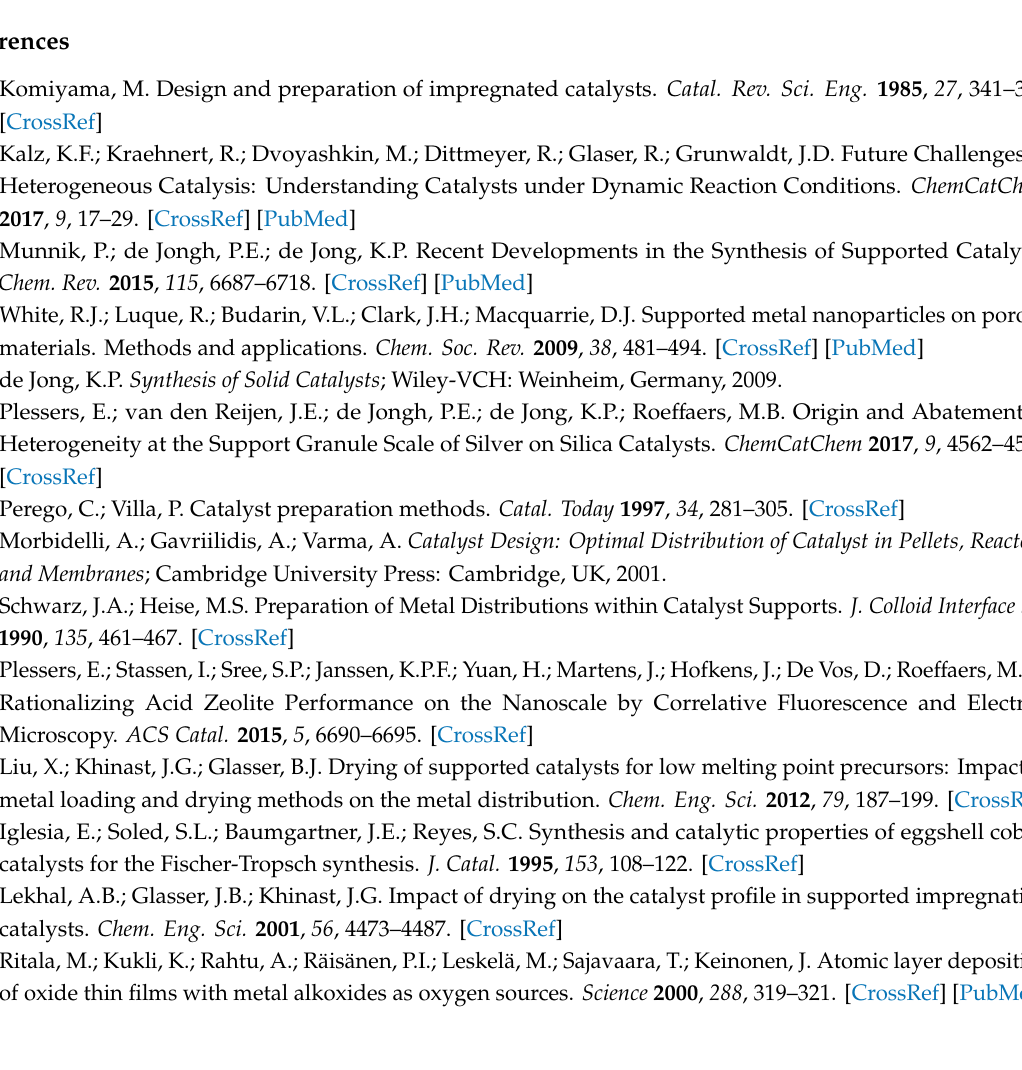
Figure A1. SEM images of the ( a ) CP-support and ( b ) RP-support. Both beads were fractured in half to observe the internal porosity.